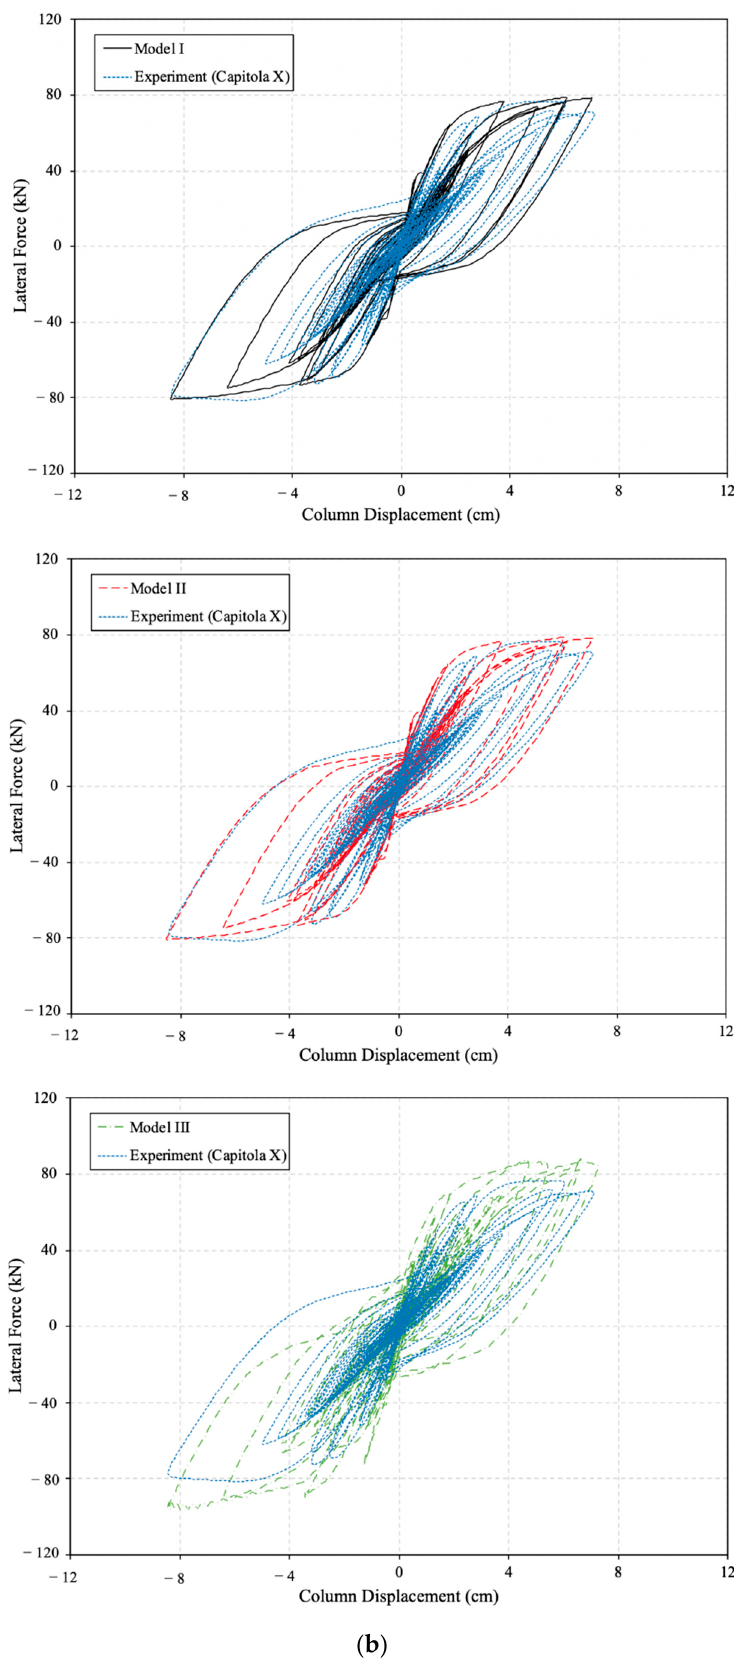
Figure 17. Force-displacement hysteresis comparison: ( a ) Curico X record; ( b ) Capitola X record.